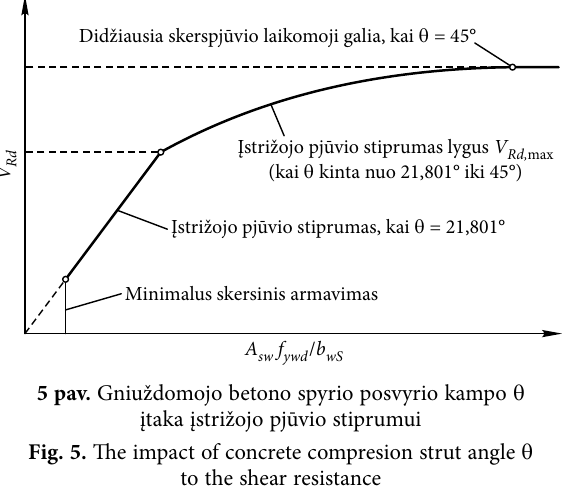
Fig. 5. The impact of concrete compresion strut angle q to the shear